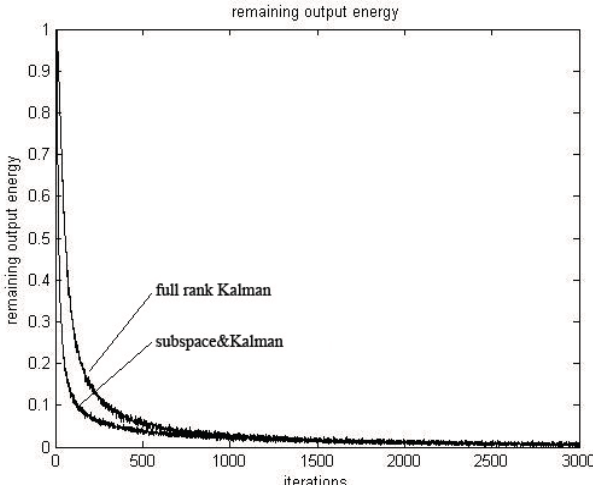
Figure 3. Under AWGN Channel with 2 0.01   , the time average remaining energy output of subspace-based Kalman filter and full-rank Kalman filter against number of